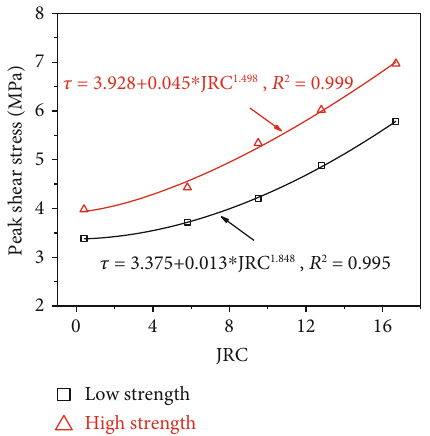
Figure 3: Relations between shear strength and JRC of joint.